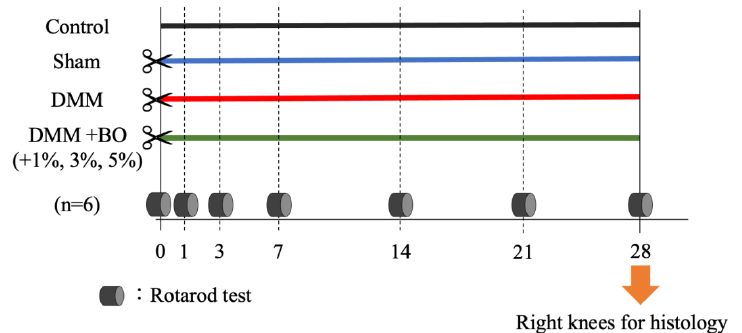
Figure 1. Experimental protocol of this study. Twelve-week-old male Wistar rats were divided into 6 groups: Control, Sham, DMM, DMM + BO 1%, DMM + BO 3%, DMM + BO 5% ( n = 6 for each). DMM was performed in the right knee in the general inhalation anesthesia. Rotarod tests were performed weekly, and then the right knees were harvested for histological analysis. BO; Boiogito, DMM; Destabilization of the medial meniscus.